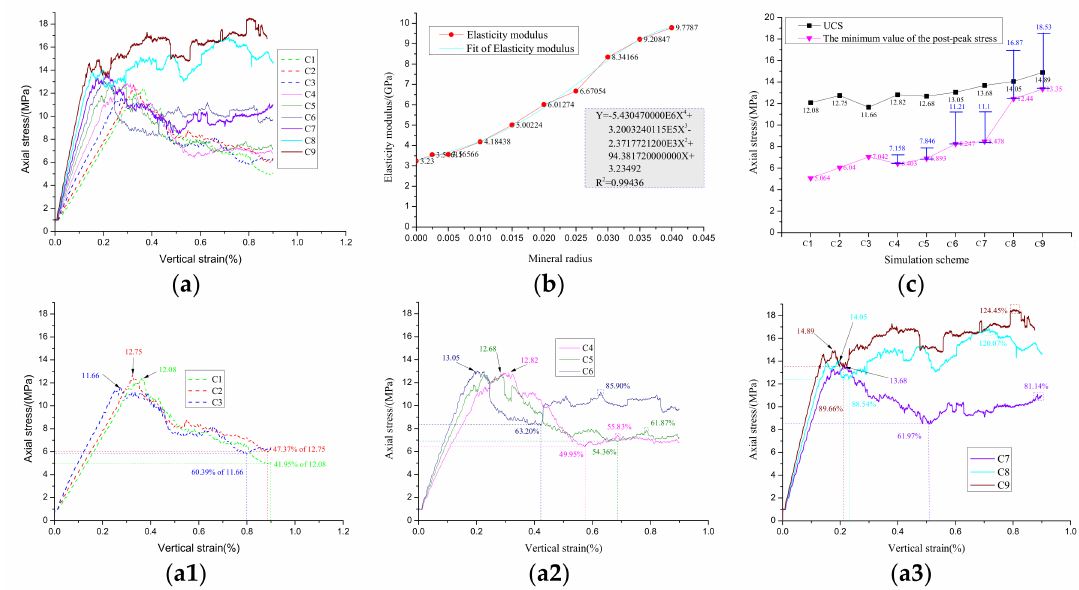
Figure 13. Mechanical characteristics of circular dimensions of different minerals: ( a ) stress–strain curve, ( b ) elastic modulus, ( c ) axial stress. a1, a2 and a3 are the stress-strain curves of C1-C3, C4-C6 and C7-C9